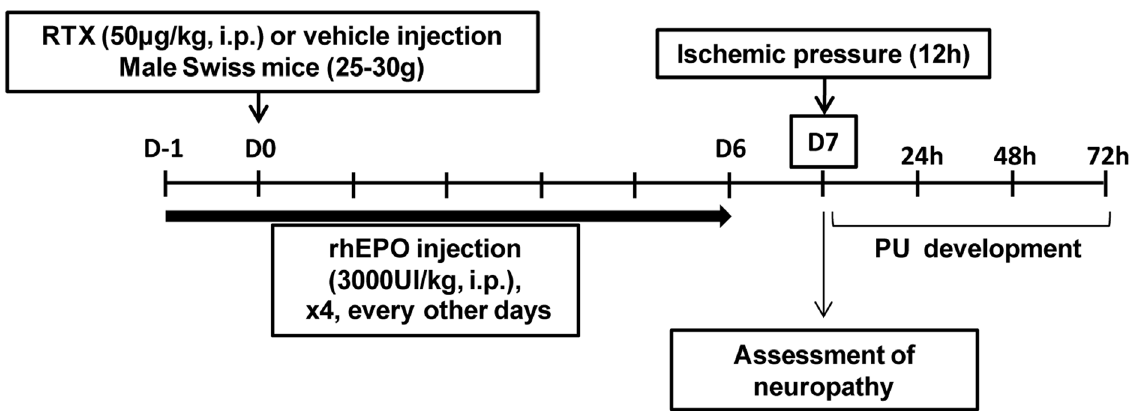
Figure 1. Schematic representation of study